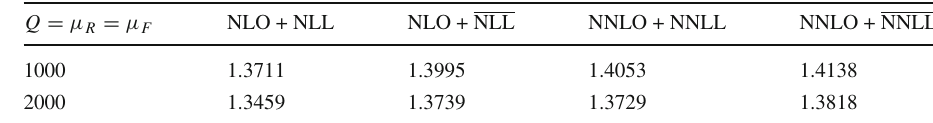
Table 8 The K-factor values for NSV resummed result in comparison to the SV resummed predictions at various logarithmic accuracy